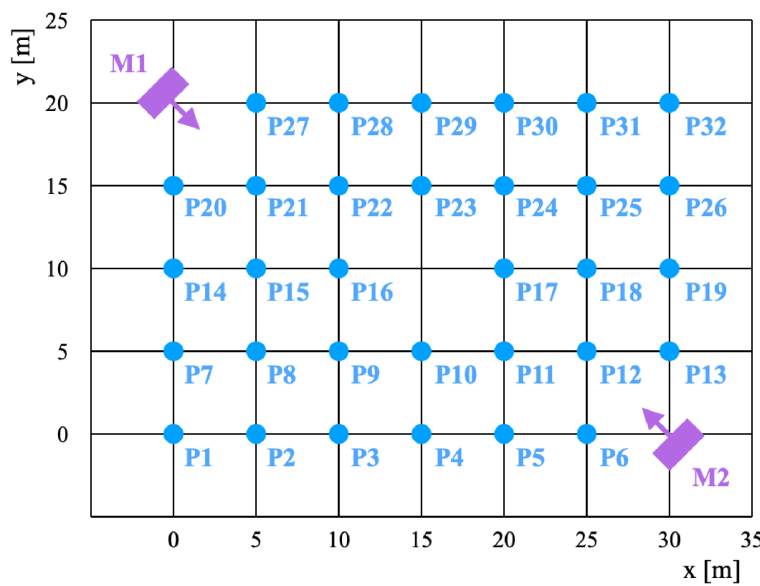
Figure 15. Setup of sound source positions and microphone arrays for Experiment C.